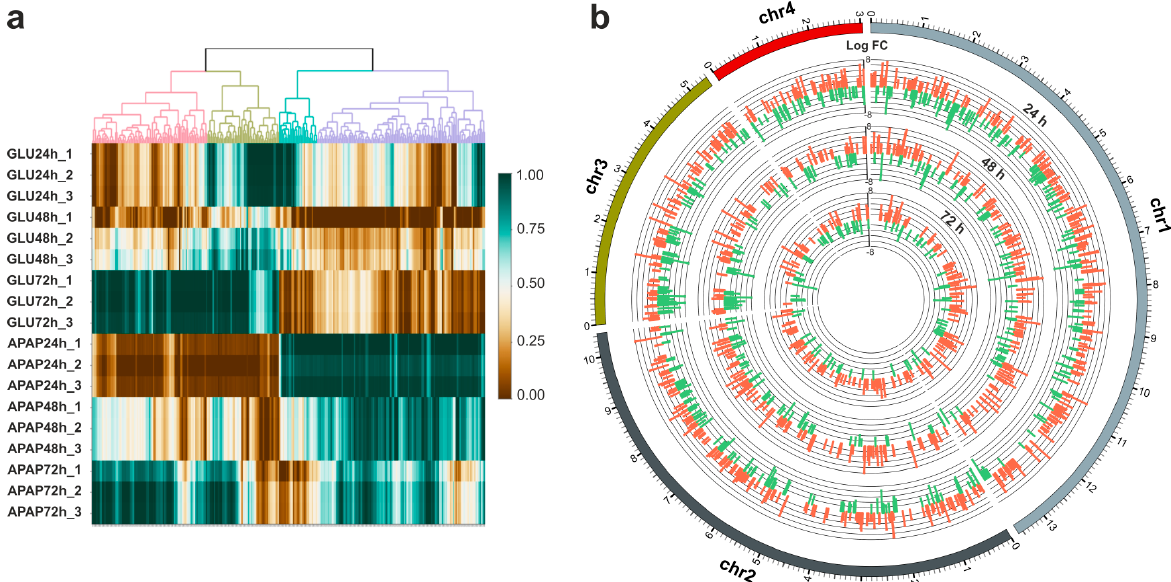
Figure 3. Spatial location and variance clustering of the differentially expressed transcripts during APAP degradation by P. chrysogenum var halophenolicum . ( a ) Variance clustering of the differentially expressed transcripts in presence of glucose or APAP as sole carbon sources, considering those with corrected p -value < 1 × 10 − 5 . ( b ) Circular depiction of the chromosome map showing the relative position of the upregulated and downregulated transcripts, and the corresponding logFc values during APAP degradation by the fungal strain. The concentric circles represent the transcriptional pattern of gene expression at 24, 48, and 72 h of incubation with APAP, where the upregulated transcripts are represented in red bars and the downregulated mRNAs in green ones. Scale in chro- mosomes is represented as millions of base pairs.